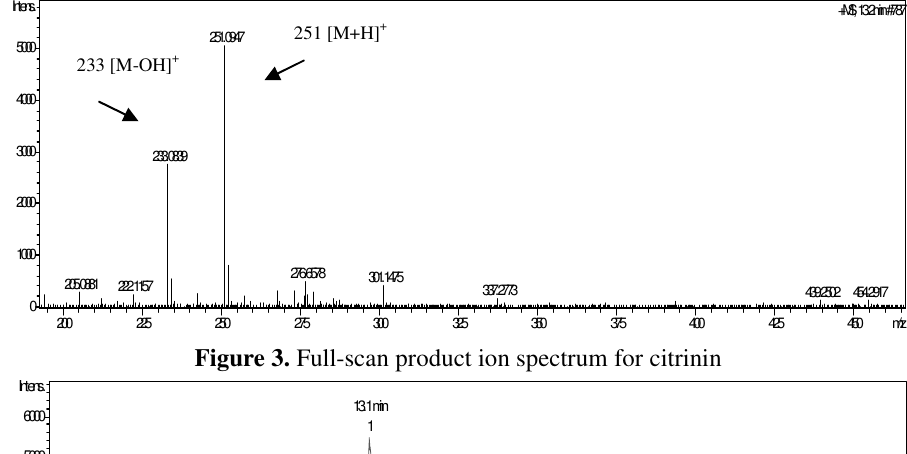
Figure 3. Full-scan product ion spectrum for citrinin